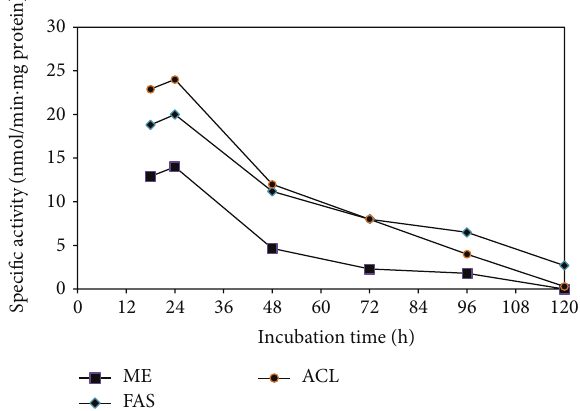
Figure 2: Specific activity of ME, FAS, and ACL of C. bainieri 2A1. The culture was cultivated in 500 mL shake flask containing 200 mL of nitrogen-limited medium at 30 ∘ C, 200 rpm, and starting inoculums of 10% (v/v). The data represent means ± SDs, 𝑛 = 3 .